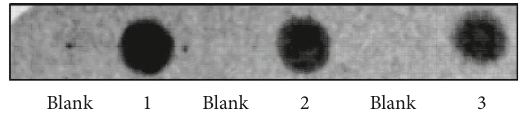
Figure 1: EGF immunoreactivity is detected in cell lysates of DOECs by using dot blot. Cells were isolated from human unstimulated whole saliva, lysed in SDS sample bufer, sonicated, boiled, and then the cell lysates were centrifuged, and the super- natants were collected for analysis. EGF immunoreactivity was assessed in samples prepared from three of the four individuals (1, 2, and 3) included in the study. Each sample was analyzed in duplicate. SDS sample bufer was utilized as